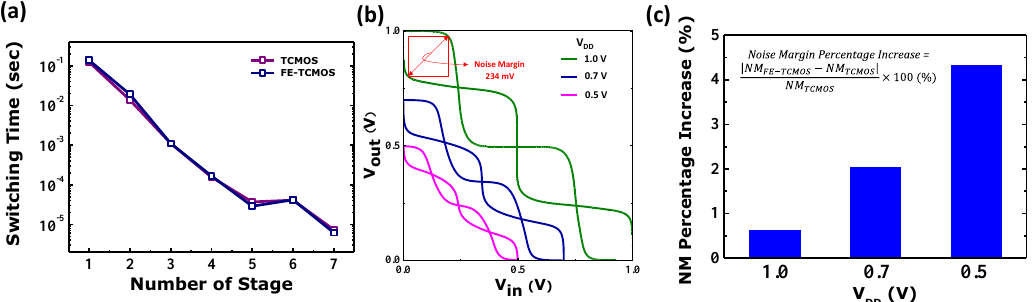
Figure 6. ( a ) The switching time comparison between TCMOS and FE-TCMOS. The switching speed di ff erence between them is negligible. ( b ) The butterfly curves of FE-TCMOS with respect to V DD . ( c ) The comparison of static noise margin between FE-TCMOS and TCMOS. The improvement of SNM in FE-TCMOS is extracted as the increase in percentage, compared to TCMOS.